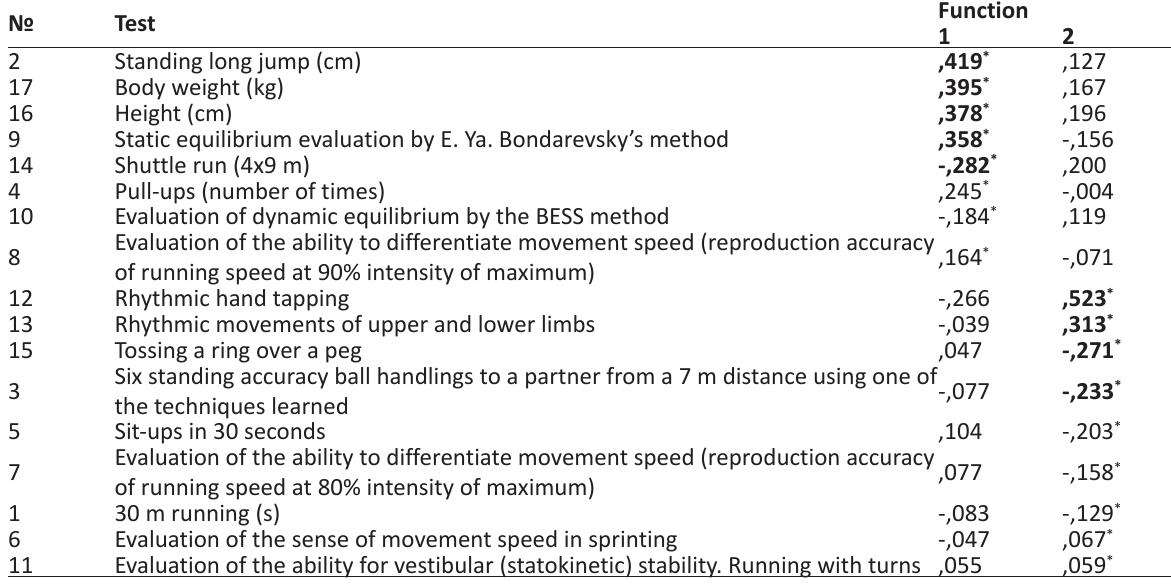
Table 4. Structure Matrix. Boys aged 11-13 years old №